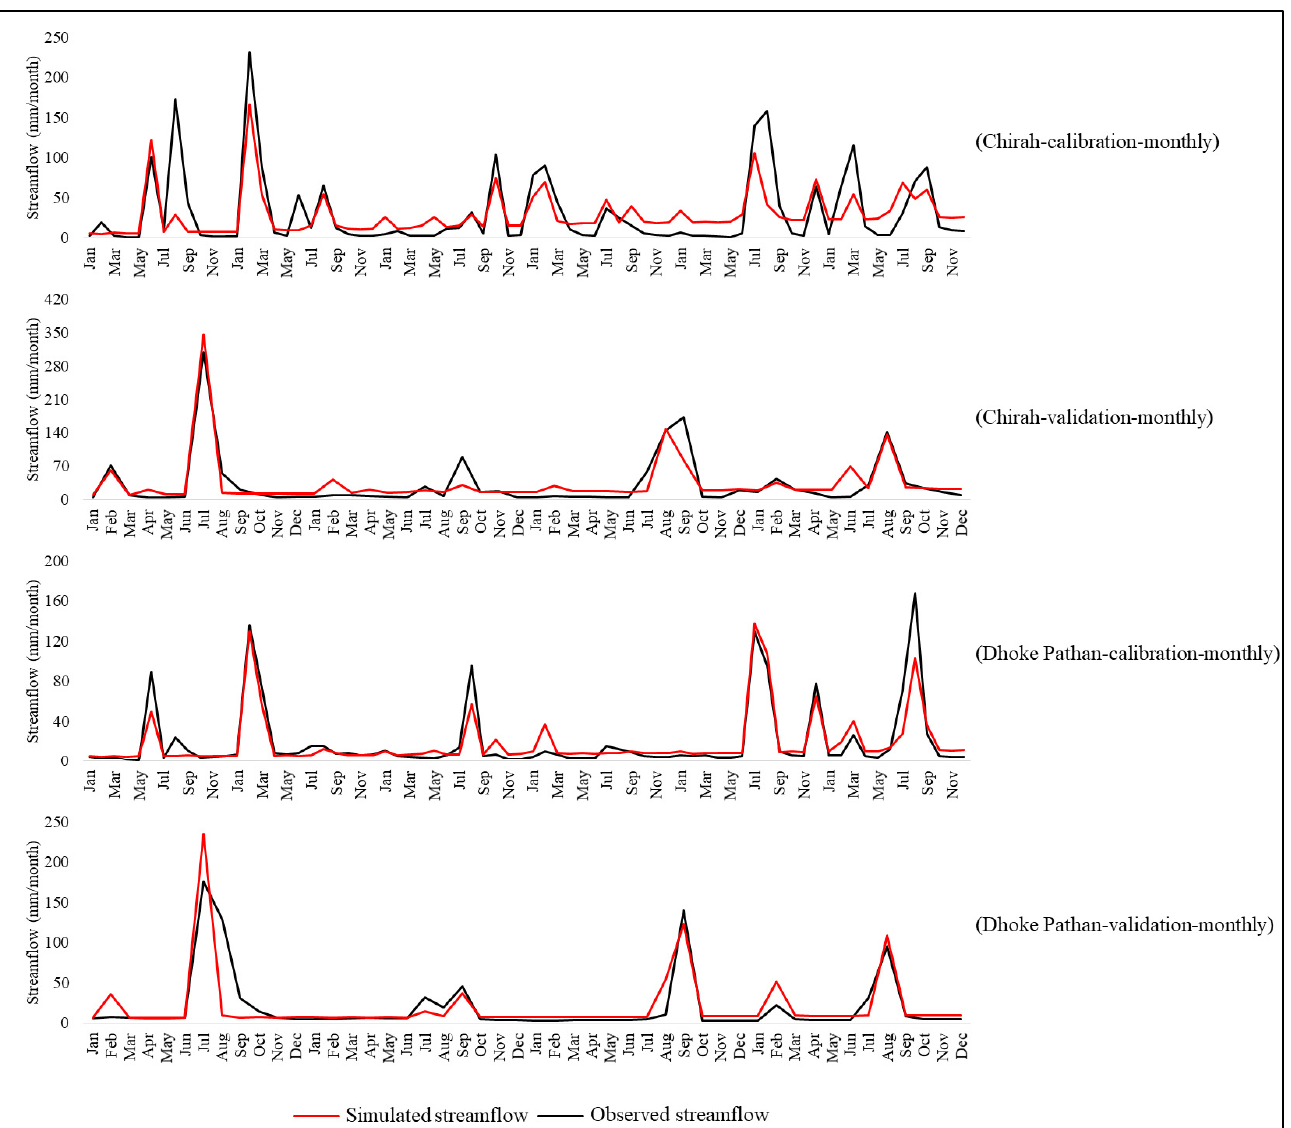
Figure 3. Monthly streamflow during calibration and validations periods simulated by the HBV-light forced with the gauged data in Chirah and Dhoke Pathan sub-catchments.